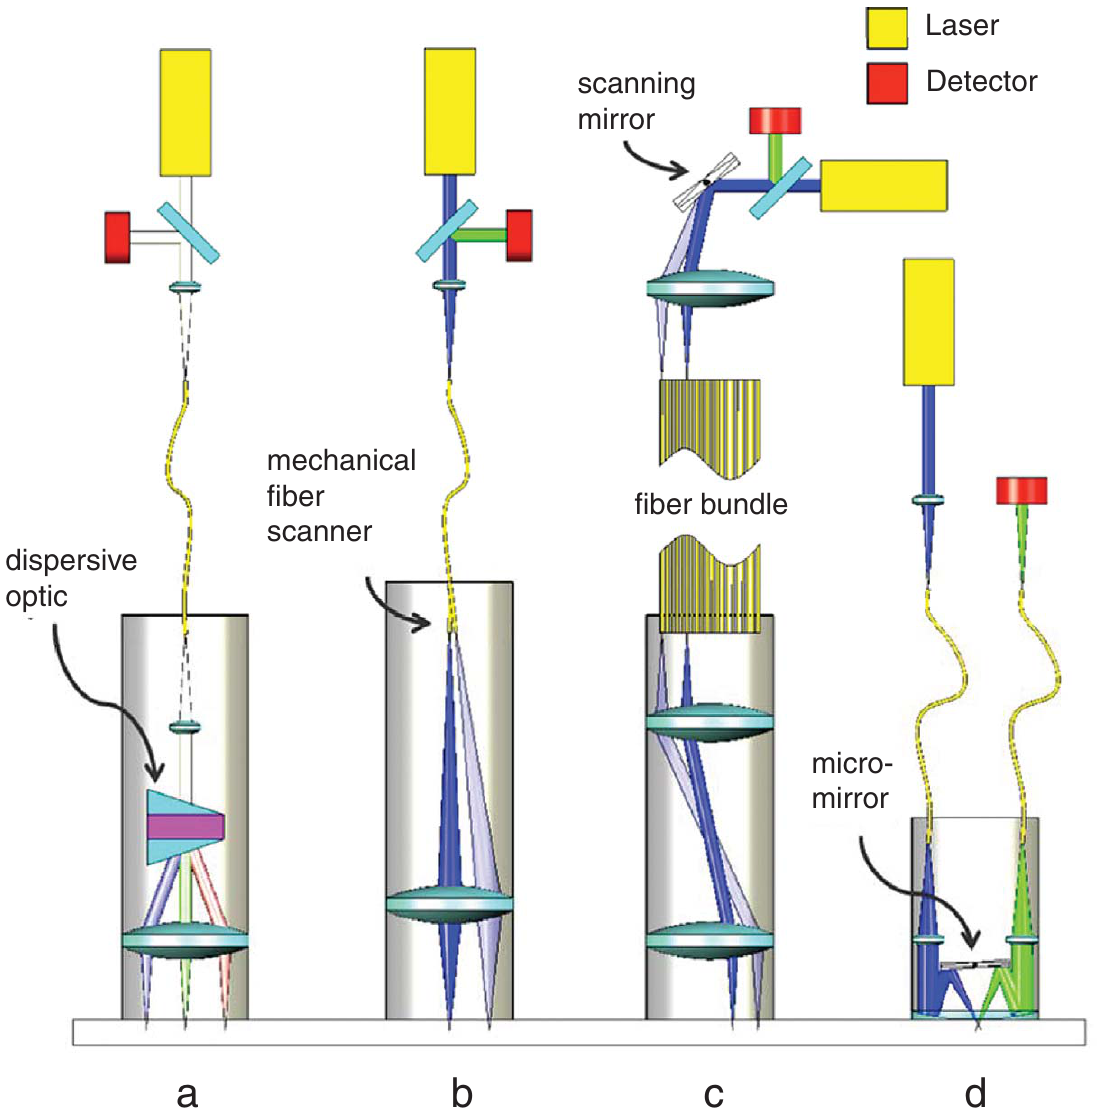
Fig. 6. a: The spectrally-encoded scanning mechanism disperses a broadband beam into multiple beams, based on wavelength, which are projected at different angles towards the objective lens, which in-turn produces a sequence of focused points along a linear path within the specimen. A line scan is achieved rapidly in one direction by either scanning the wavelength of the laser source, or by using a broadband light source. In the latter case, the reflected light that is collected must be analyzed with a spectrograph in order to decode spatial location from the wavelength components of the signal. b: The resonant fiber scanning mechanism uses the end of a single-mode fiber to serve as both the point source and point detector of a confocal microscope. This system can be used to gather an image by providing a mechanism for vibrating (deflecting)theendofthefiberinaresonantsinusoidalpatterntoscanthefocalspotwithinthespecimen.Thebluebeamrepresentstheexcitation light, which is absorbed by the fluorescent molecules in the specimen. The green beam represents the fluorescence emission light collected by the end of the fiber and then directed to a detector. c: The fiber-bundle scanning mechanism uses the ends of multiple fibers to provide multiple point sources and point detectors for a large number of parallel confocal microscopes, each imaging a single point (pixel) within a 2D image. Beam scanning is performed on the proximal end of the fiber bundle (away from the patient) where each fiber is illuminated sequentially in time. d: A miniature dual-axis confocal microscope is depicted, where a fast electrostatically driven MEMS scanning mirror steers the excitation and emission beams along two orthogonal directions for 2D imaging. Two separate single-mode fibers act as a point source and point detector,